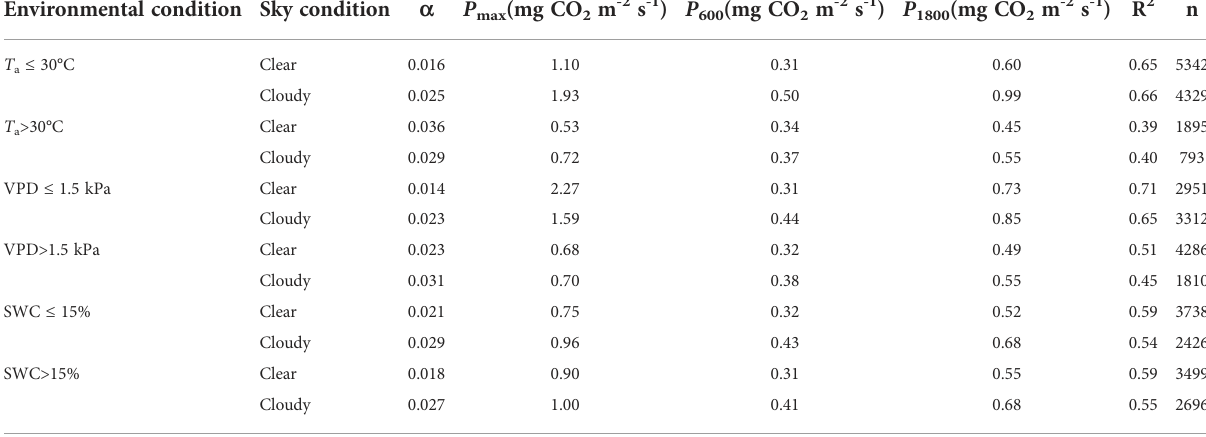
TABLE 2 Light response parameters estimated by the MM model under different environmental